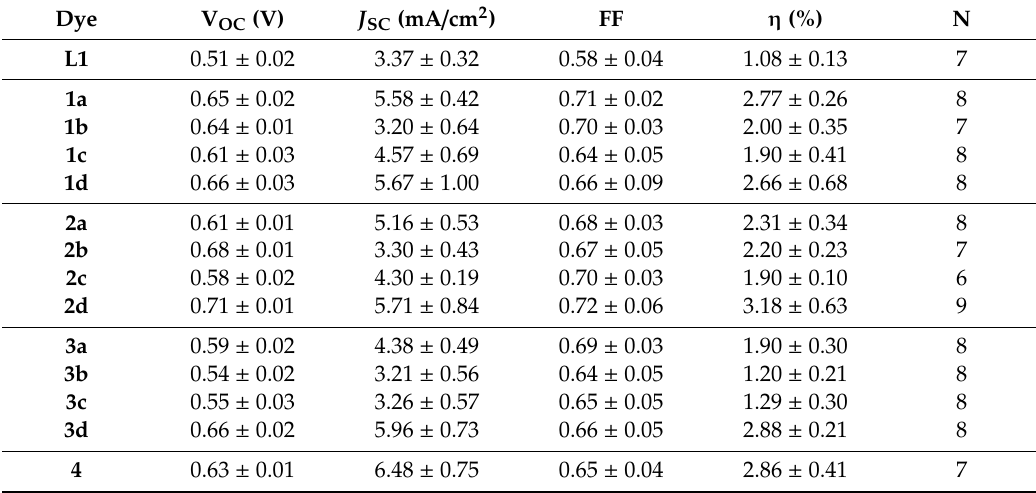
Table 2. Photovoltaic performance of DSSCs based on the extended bichromic-bipodal dyes, compared to benchmark L1